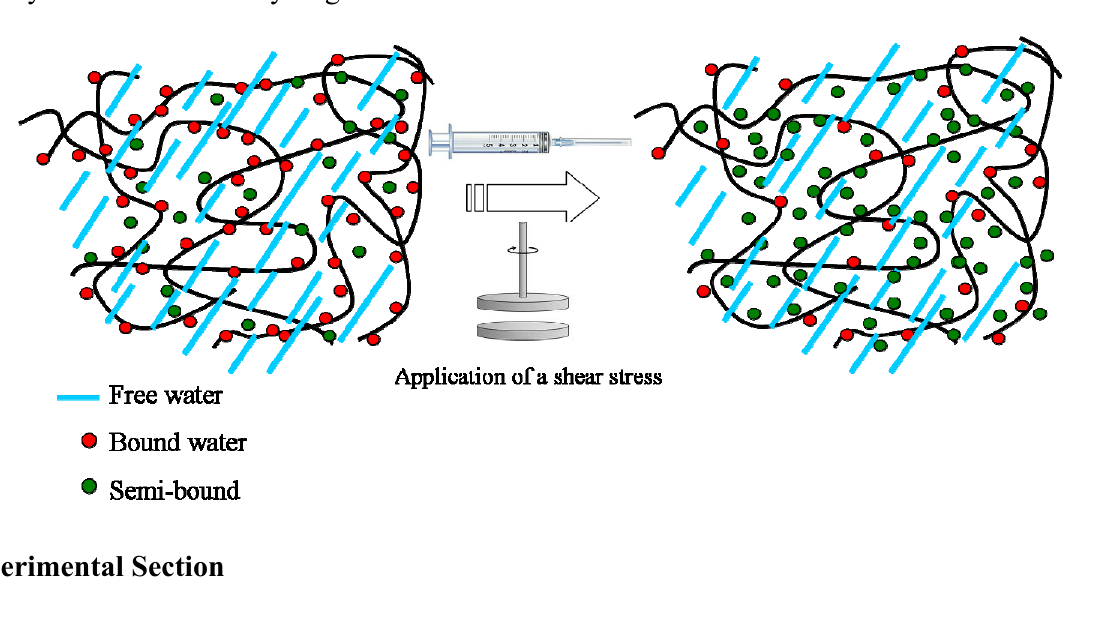
Figure 9. Schematic drawing showing the arrangement of water molecules inside a polysaccharide-based hydrogel in the native state and under